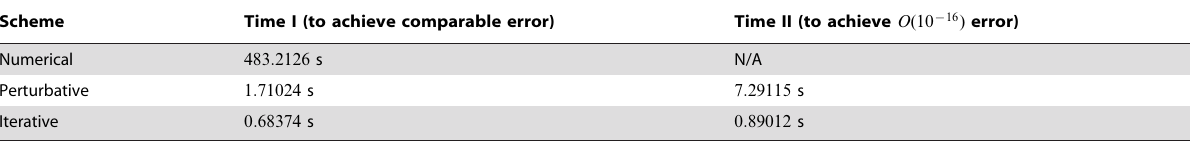
Table 6. Timing results for three frequency response algorithms.